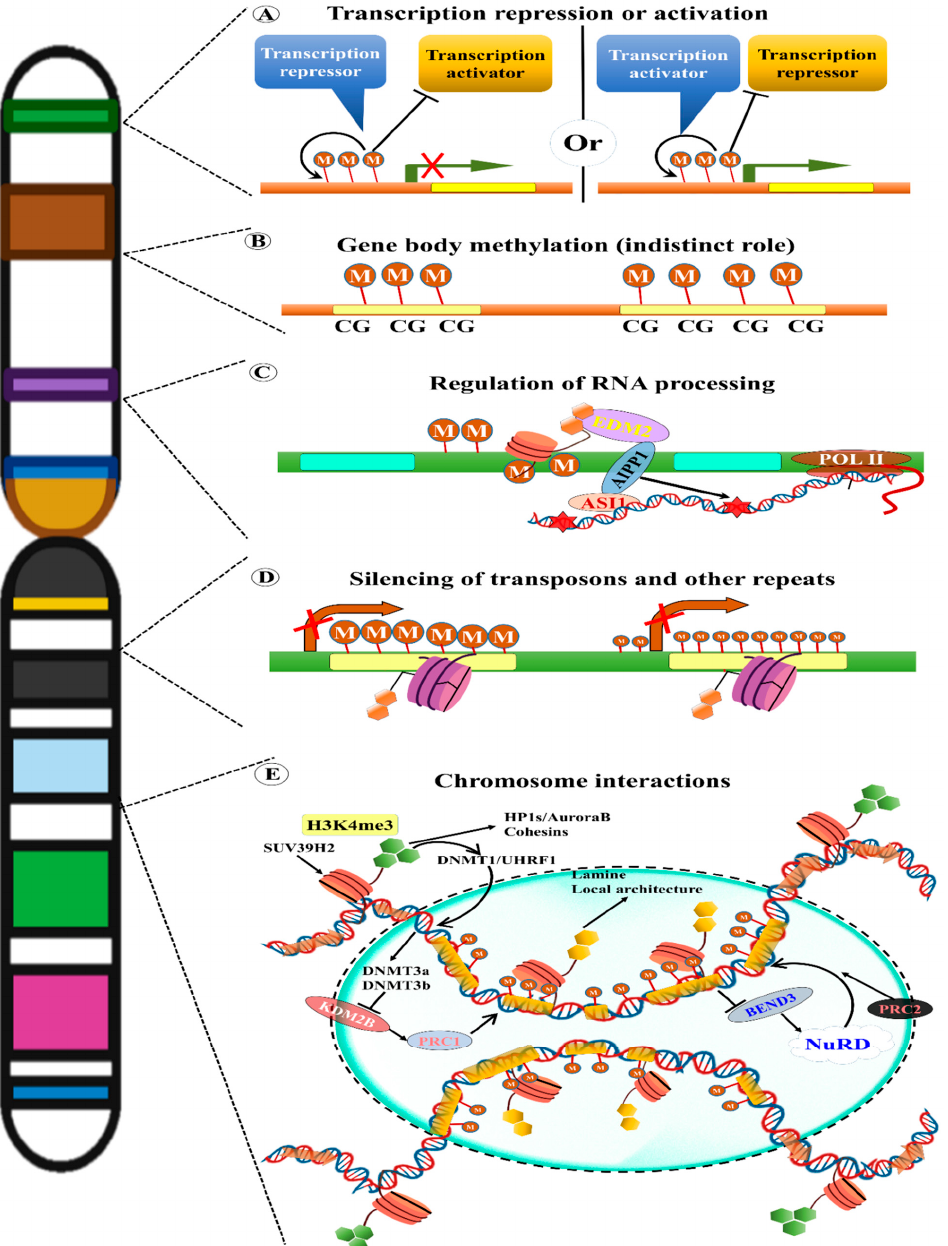
Figure 2. Cellular functions of DNA methylation (m) in the plant genome. DNA methylation regulates transposon activation, gene regulation, and chromosome interactions. ( A ) Methylation in the gene promoter either represses or activates transcription [229–233]. ( B ) Gene body methylations mainly occur in the CG context, although its function remains unknown [42,231,234–236]. ( C ) DNA methylation in heterochromatin regions causes the ASI1-AIPP1-EDM2 complex